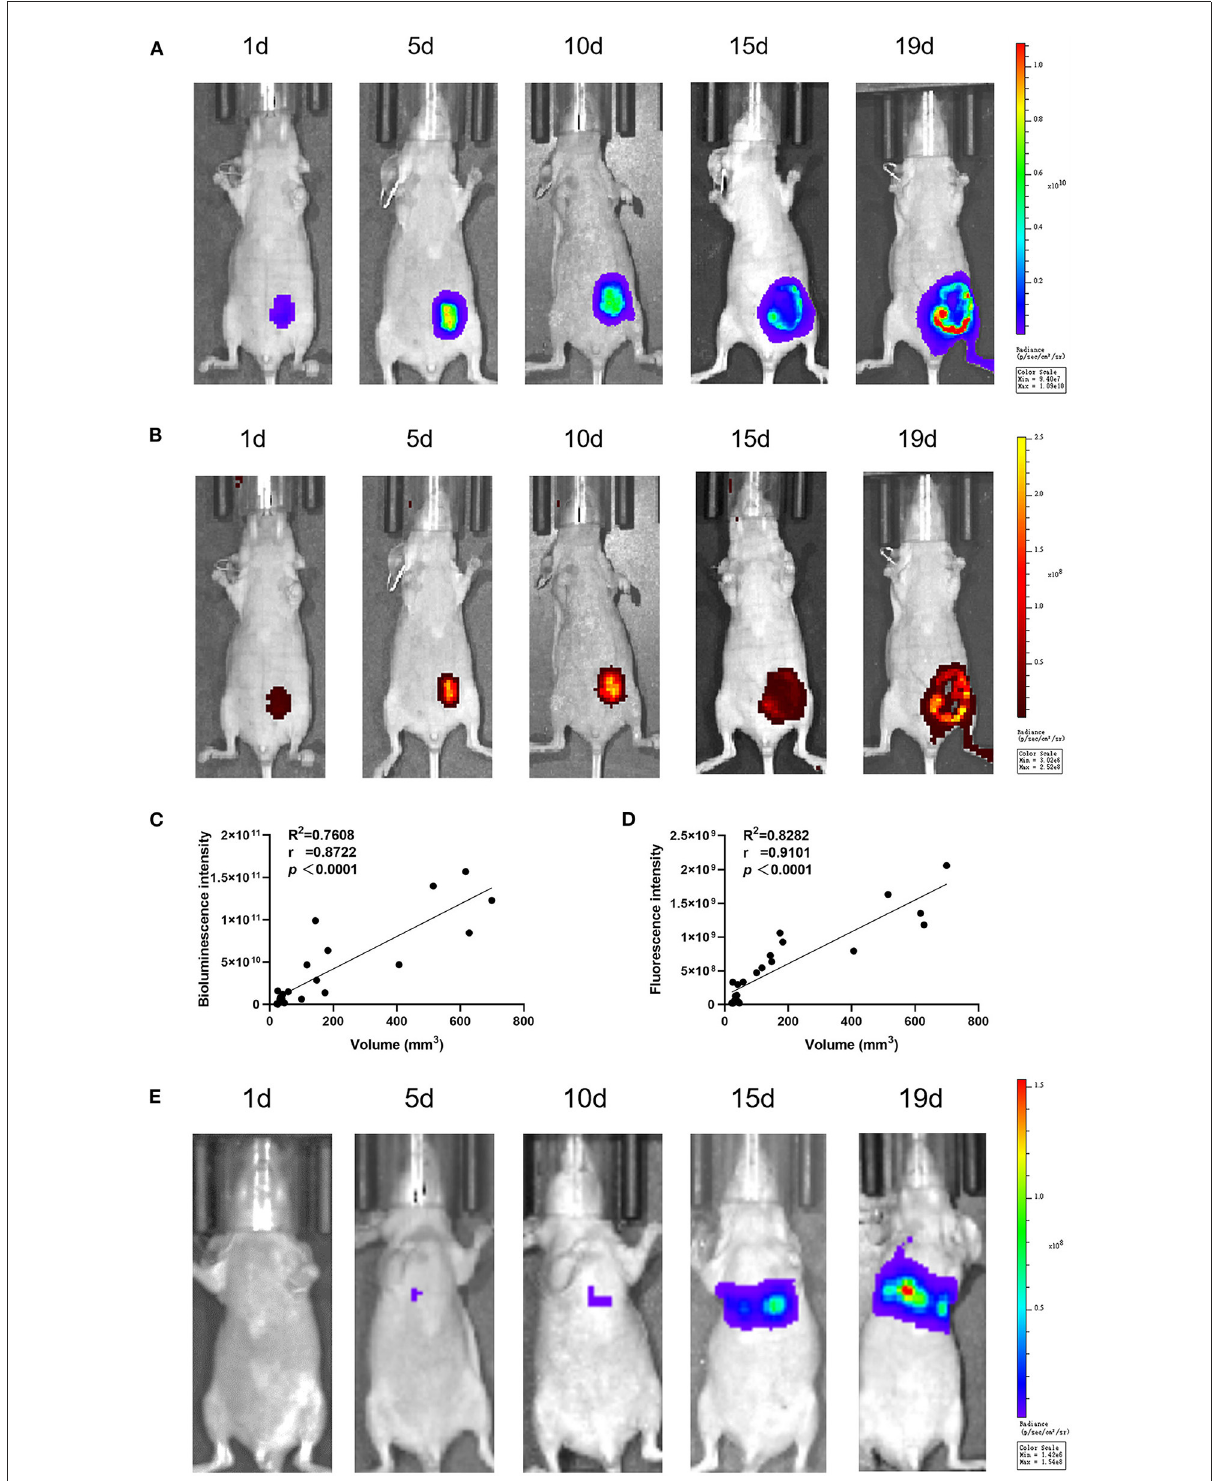
FIGURE3 In vivo luminescent intensity of CHMp-Luc-EGFP cells. At 1, 5, 10, 15, and 19 days after implantation, luminescence and fluorescence images were captured with the IVIS imaging system. (A) Bioluminescence imaging of the primary-tumor model. (B) Fluorescence imaging of the primary-tumor model. (C) Correlation analysis between luminescent intensity and days after implantation. (D) Correlation analysis between luminescent intensity and tumor volume. (E) Bioluminescence imaging of the metastatic tumor model. n =